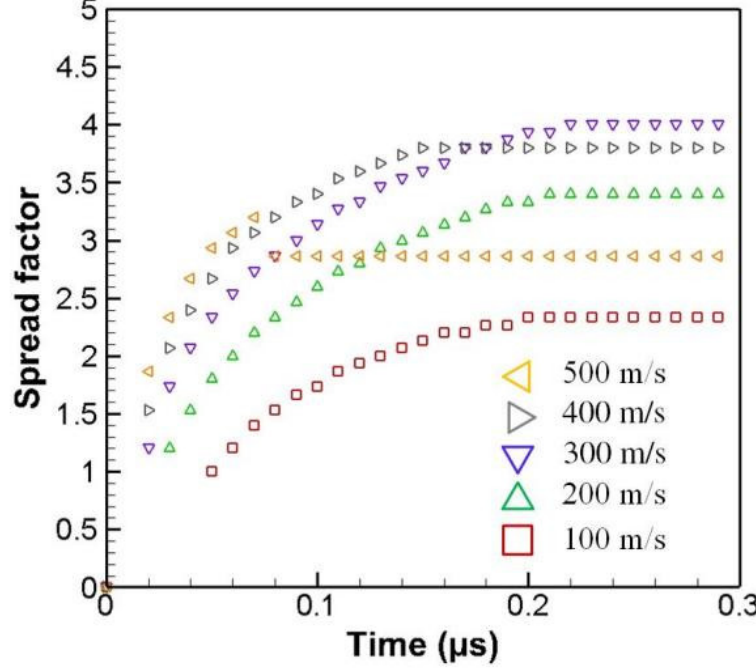
Figure 14. Spread factor evolution for Ni drop at different velocities.